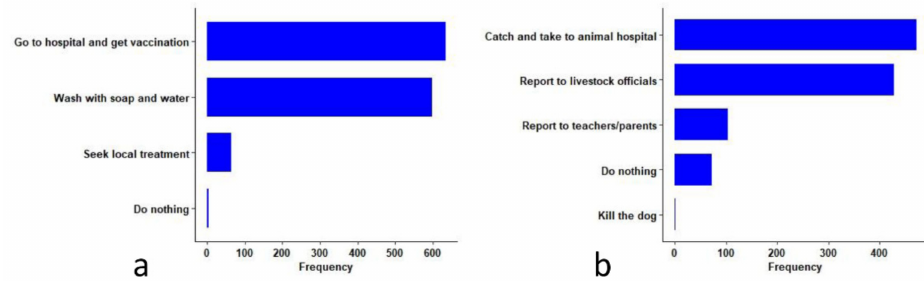
Figure 4. Students’ perceptions on rabies: ( a ) what they would do if they were bitten by a rabid dog; ( b ) what they would do if they saw rabid dog in the streets. Each bar in the graph represents frequency of the positive responses by total students who heard about rabies ( n = 688) to the specific cause, hosts, routes, and clinical signs of